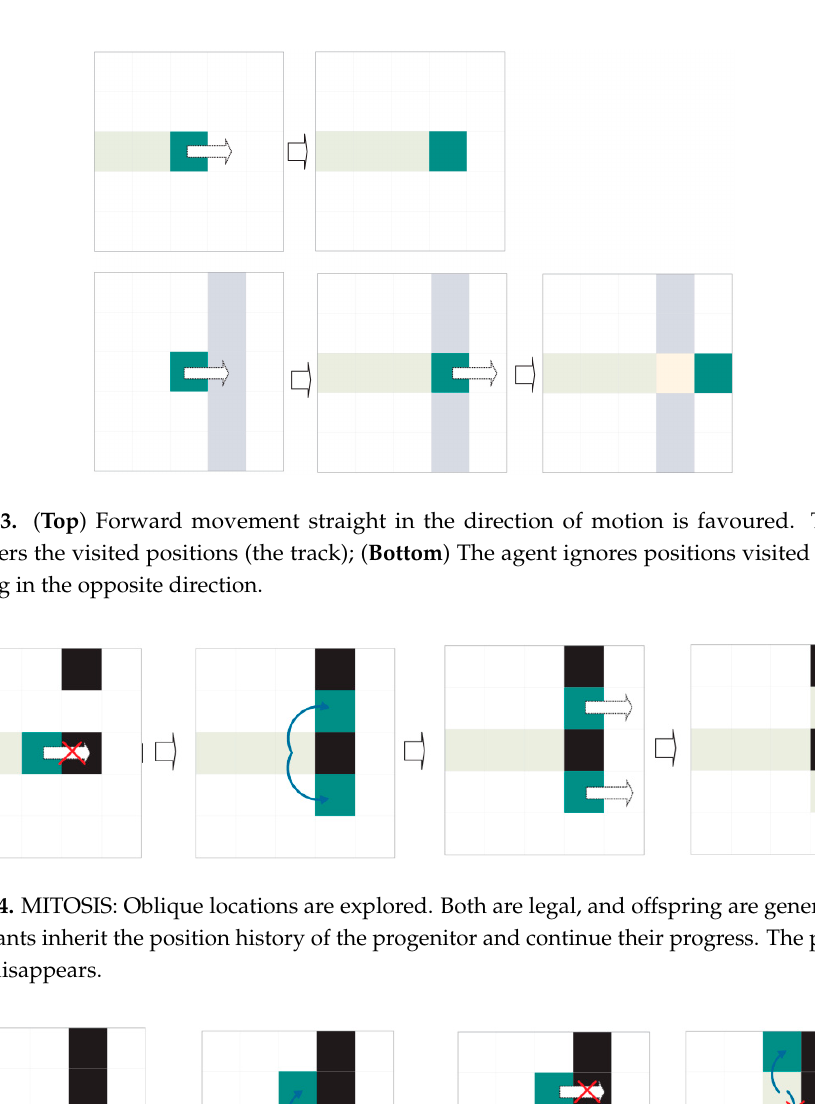
Figure 13. ( Top ) Forward movement straight in the direction of motion is favoured. The agent remembers the visited positions (the track); ( Bottom ) The agent ignores positions visited by agents travelling in the opposite direction.